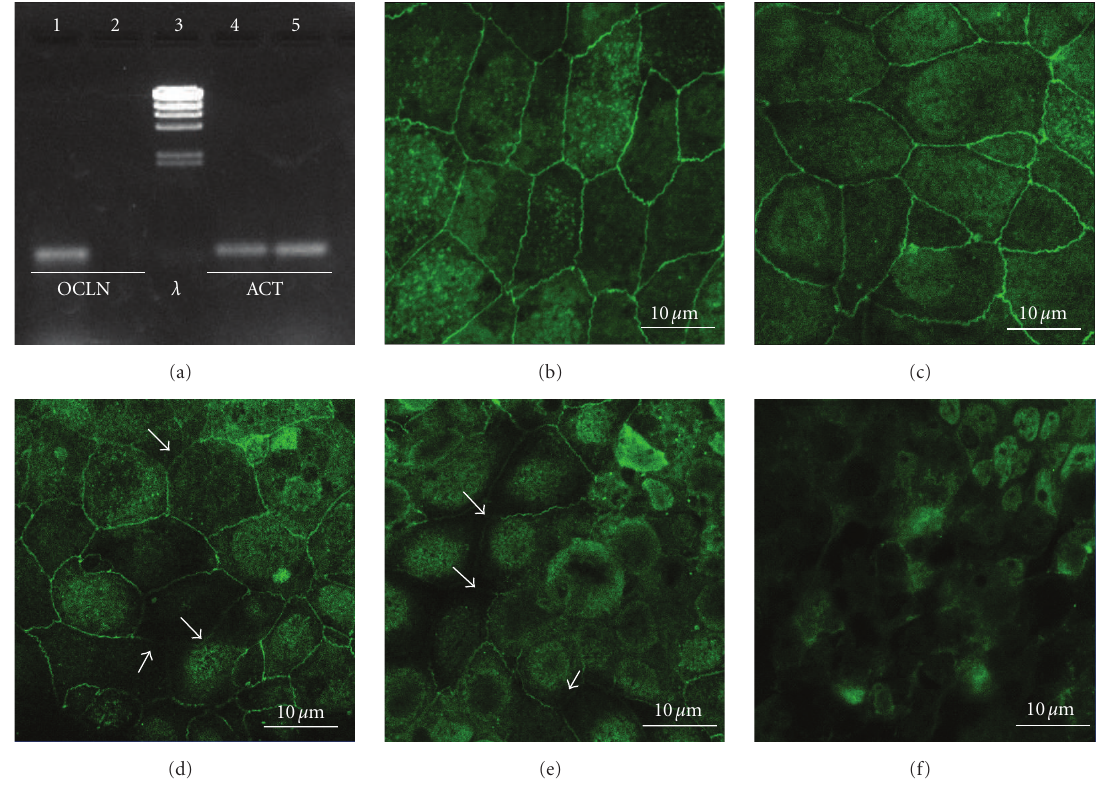
Figure 3: E ff ect of LV transduction on occludin localization . Expression of occludin mRNA by RT-PCR (a). Note that occludin (OCLN) transcript is detected in 16HBE14o- cells (lane 1) but not in PBMCs (lane 2). β -actin (ACT) transcripts were detected in 16HBE14o- and PMBCs (lanes 4 and 5, respectively). In lane 3, λ HindIII marker. Polarized 16HBE41o- cells were incubated with 50 (C), 500 (D) or 2000 (E) MOIs and, 24 hours later, occludin localization was evaluated by immunofluorescence and confocal microscopy. Controls included mock cells (B) and cells treated with 12 mM EGTA for 30 minutes (F). En-face micrographs are shown. Occludin-specific signal is in green. A peripheral chicken-wire pattern of occludin localization is noted in B and C. In D and E, white arrows point out to lack of occludin staining at cell borders and between cells. In F, occludin staining is lost from cell borders and distributed intracellularly. Note that some intracellular signal is visible also in B-E. Bar: 10 μ